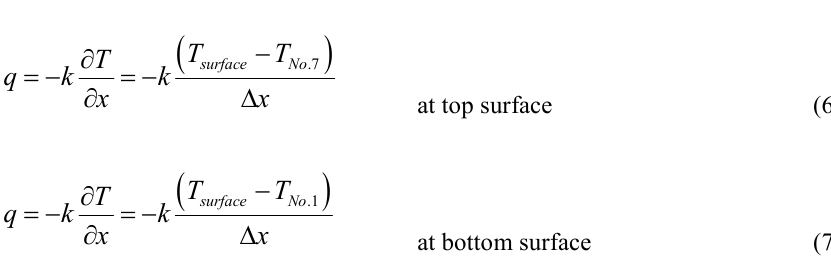
Fig. 5 Temperature distribution: (a) S0, R